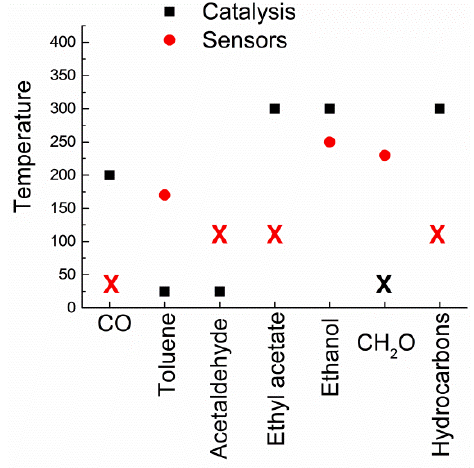
Figure 3. Best operating temperatures for the indicated sensing (best operating temperature and response tradeoff) and oxidation (lowest total combustion temperature) experiments over Cr 2 O 3 materials. The crosses, not to be referred to any particular temperature, indicate the applications for which no adequate references could be found. The references are reported in the discussion.